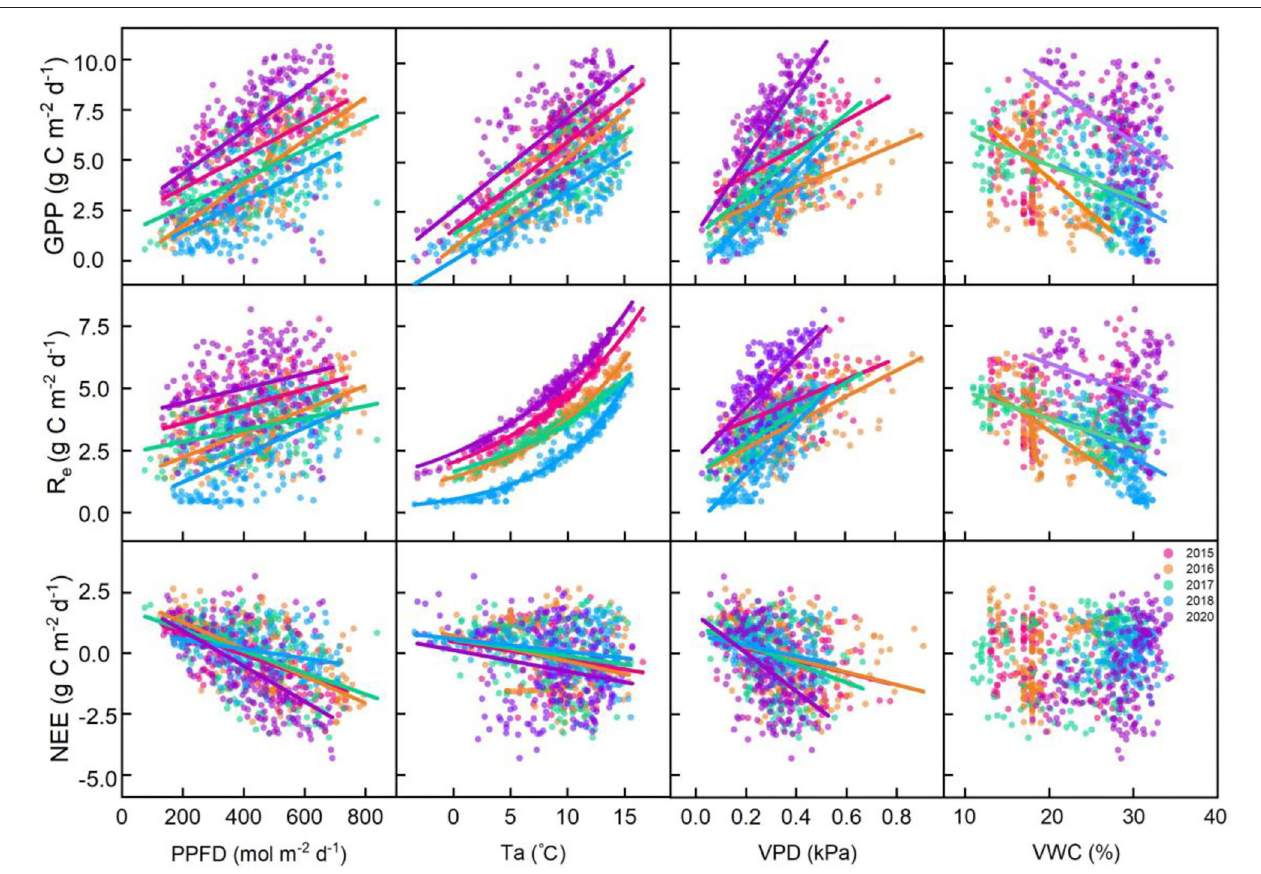
FIGURE 5 | Relationships between daily carbon fluxes (gross primary productivity [GPP], ecosystem respiration [Re], and net ecosystem carbon dioxide (CO 2 ) exchange [NEE]) and environmental factors (the photosynthetic photon flux density (PPFD), air temperature (Ta), vapor pressure deficit (VPD), and volumetric water content at a depth of 5cm (VWC at 5cm)). The fitted lines indicate that the regressions are significant under the confidence of 0.05.